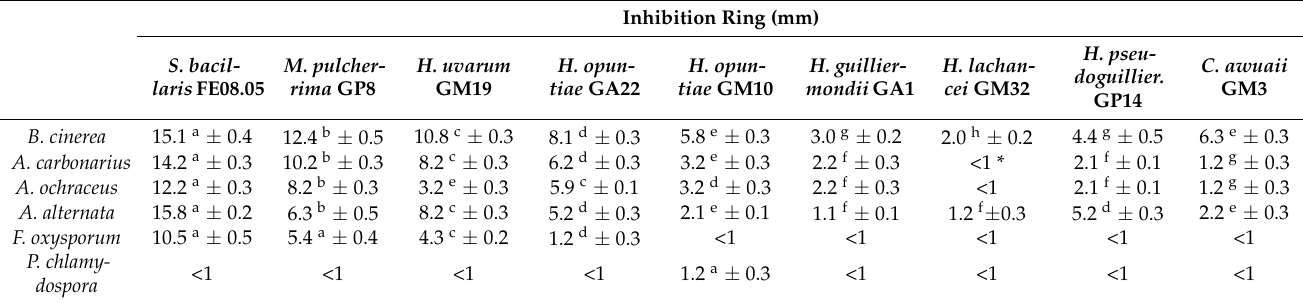
GP14) and Candida awuaii GM3. Results are the mean of three replicates. For each pathogen considered, different letters indicate significantly ( p < 0.05) different inhibition on the basis of ANOVA and TUKEY HSD tests.